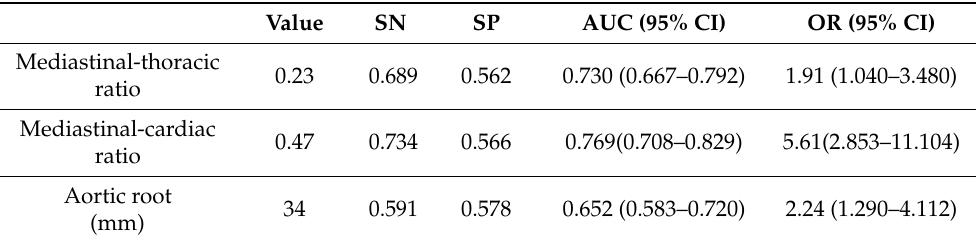
Table 3. Cut off values of simple chest radiographic and echocardiographic parameters for prediction of catheter